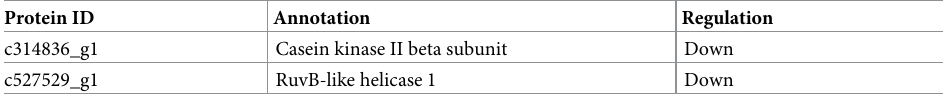
Table 5. DAPs involved with Wnt signaling in ND1 vs D1 comparison based on KEGG analysis.